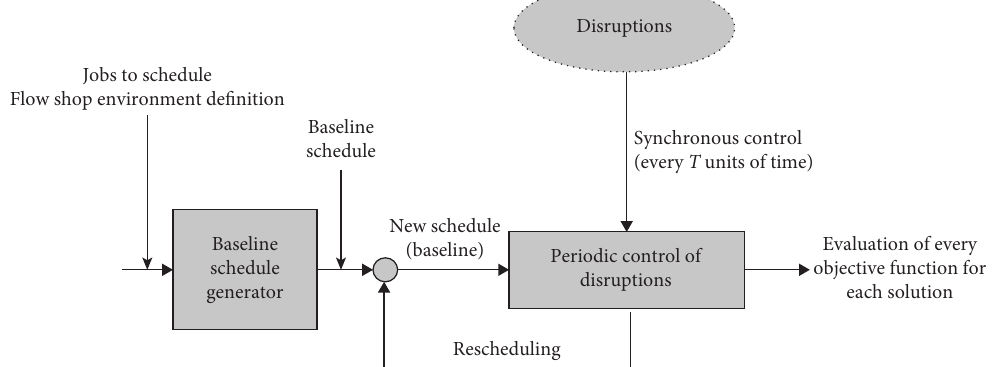
Figure 1: Rescheduling architecture.